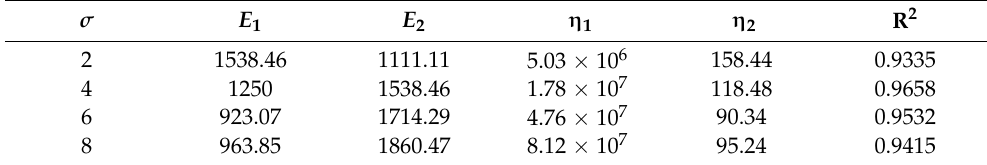
Table 2. Creep parameters under the first four stress grades.